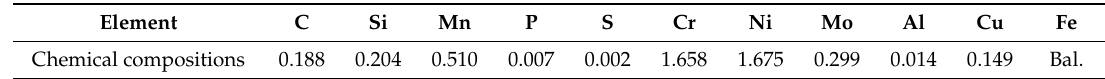
Table 1. Chemical compositions of 18CrNiMo7-6